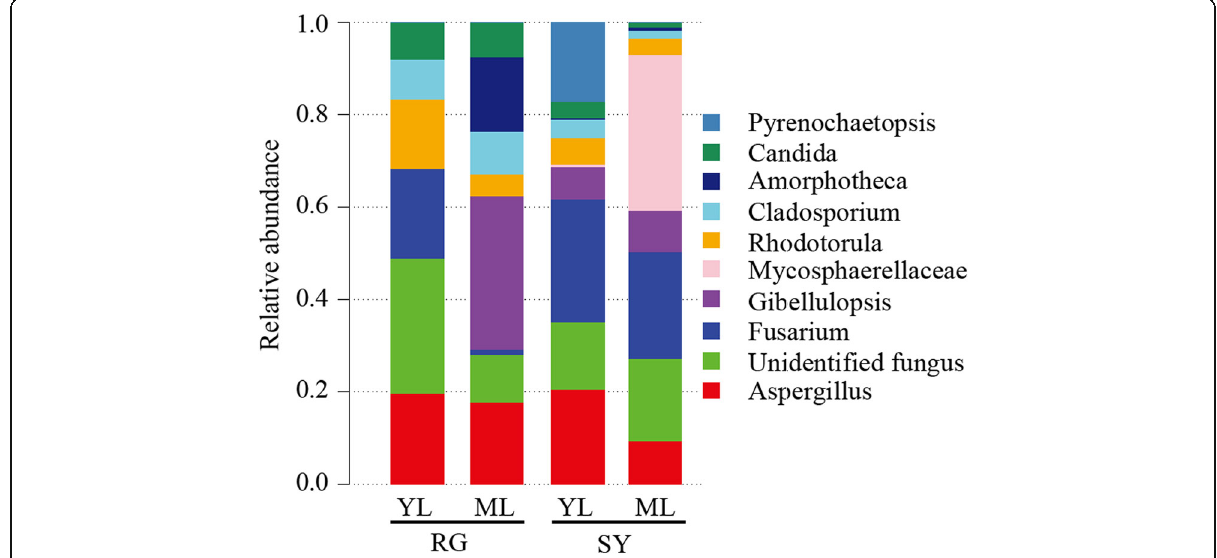
Fig. 2 Relative abundance of fungi identified as endophytes in grape samples at genus level. Stacked bar plots represent mean relative abundances of fugal endophytes within